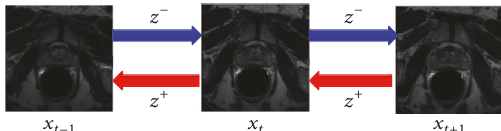
Figure 12: The 𝑧 − direction and 𝑧 +